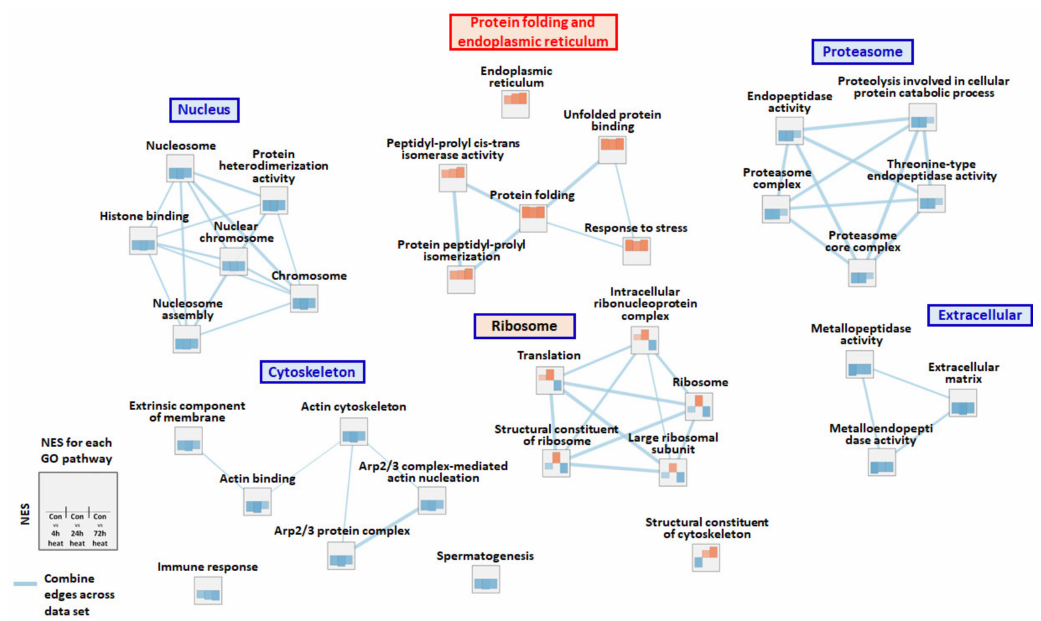
Figure 2. Enrichment map for the shared gene ontology (GO) pathway with p < 0.05 and False discovery rate (FDR) < 0.25 during thermal stress. Normalized enrichment scores at 4, 24, and 72 hpt are shown in each node, and the thickness of the light blue edges between the nodes indicates the overlap coe ffi cient across the datasets (4, 24, and 72